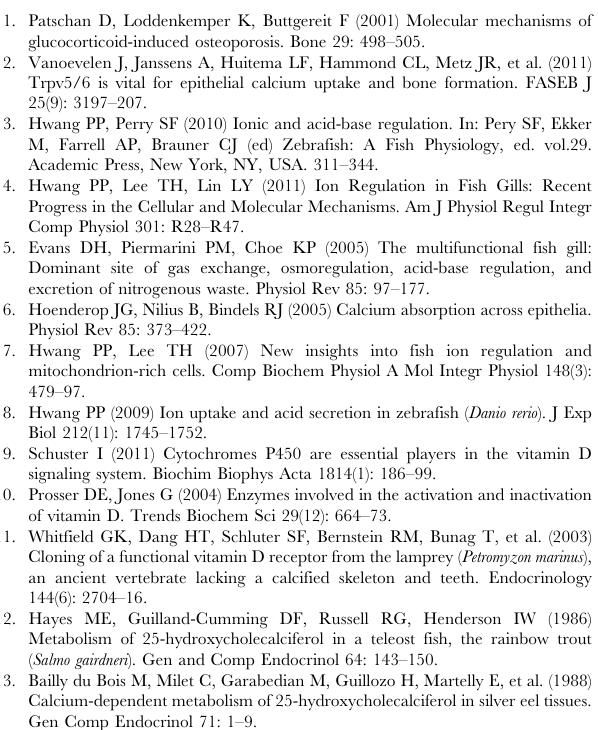
Figure S2 Effect of vitamin D receptor (VDR)a and VDRb morpholino oligonucleotides (MOs) on ossifica- tion of vertebrae of 5-d post-fertilization (dpf) zebrafish embryos. Control (A), VDRa (B), and VDRb (C) MO. Ossification of vertebrae was observed by calcein staining. Scale bar: 100 m m. (TIF) Figure S3 Colocalization of vdra mRNA with Na,K- ATPase rich (NaR) cells in zebrafish gill cryosections. (A) In situ hybridization of vdra mRNA; (B) immunocytochemical staining of Na,K-ATPase. The arrow indicates colocalization of vdra mRNA and Na,K-ATPase protein signals in the same cells. Scale bar: 5 m m. (TIF) Table S1 Primers for the RT-PCR and qPCR analyses. (DOCX) Table S2 Identities (%) of amino-acid sequences among the DNA-binding domain (DBD) and ligand-binding domain (LBD) of vitamin D receptors (VDRs) in different species.